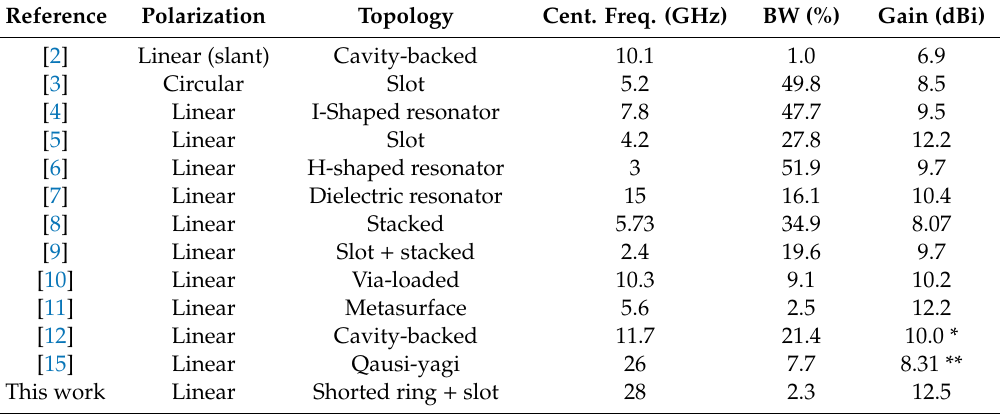
Table 1. Comparison of the proposed antenna performance with the other antenna